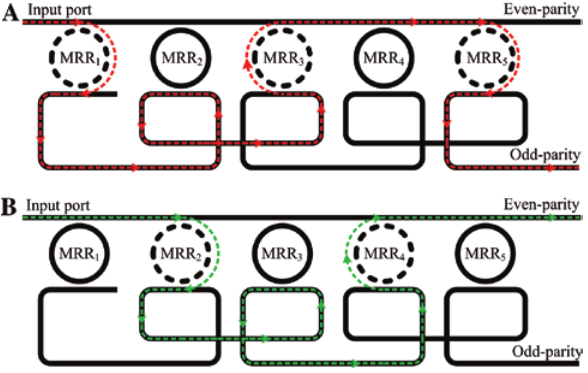
Figure 2: Two pathways of light propagating from input port to the corresponding output port.